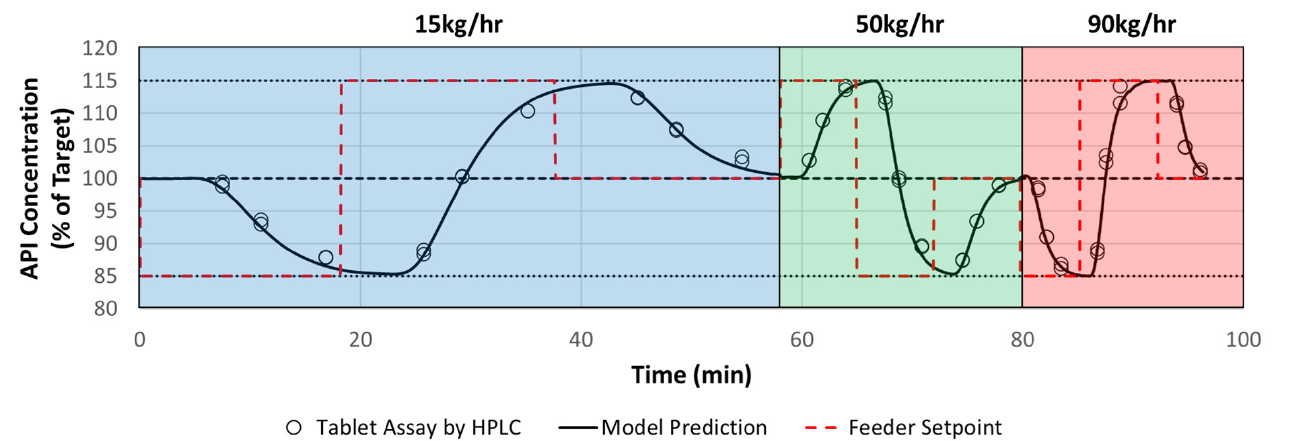
Figure 15. Model Validation Comparison of Tablet Assay to RTD Model Prediction.